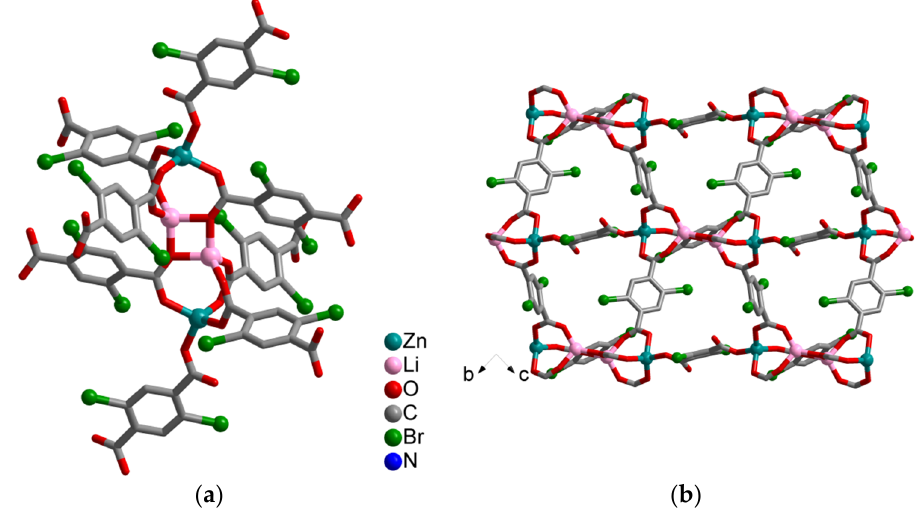
Figure 3. ( a ) SBU in compound 2 ; ( b ) Structure view of 2 along a axis.